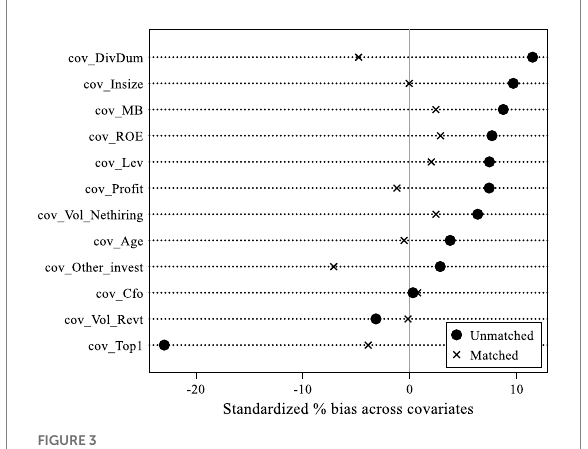
FIGURE 3 Balance Test. This figure reports the test for the proximity of treatment and control group covariate means after matching.